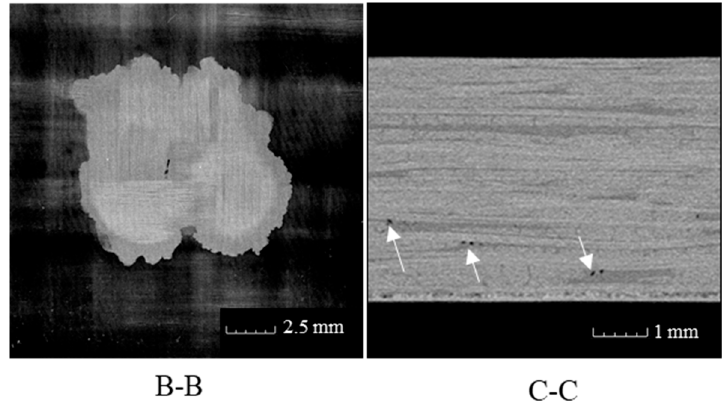
Figure 15. CT scan of a controlled weld spot without the presence of the thermocouple. The weld was done under similar conditions and with parameters as the C-5 case.